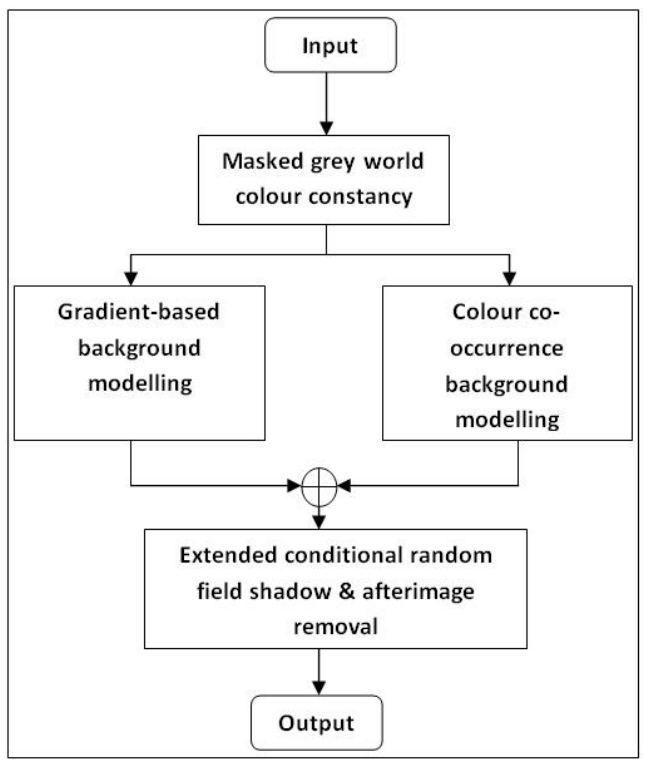
Figure 1. Block diagram of the overall